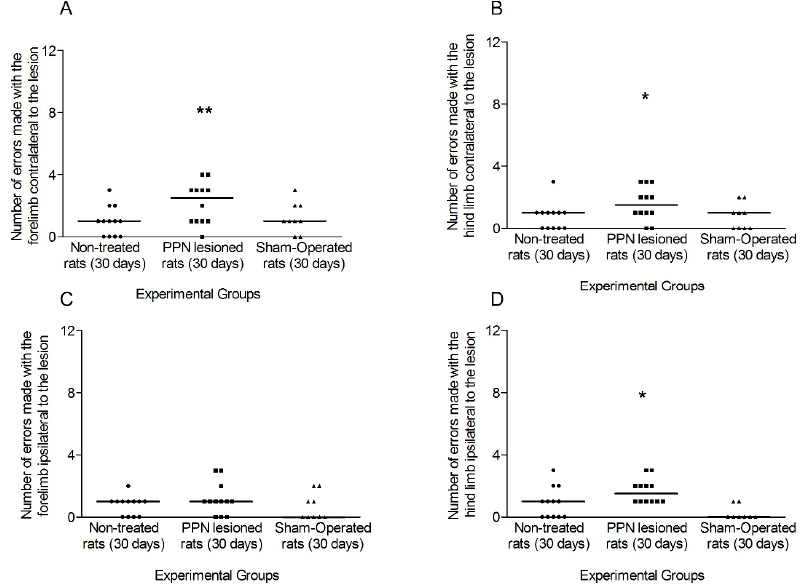
Figure 8. Comparison of the faults made by each limb separately during the execution of grid test, 30 days after pedunculopontine nucleus lesion. ( A ) Faults made by the contralateral forelimb (H (2,33) = 9.65 p <